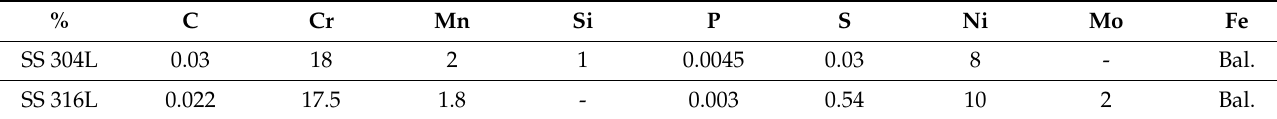
Table 1. Chemical composition of 316L and 304L